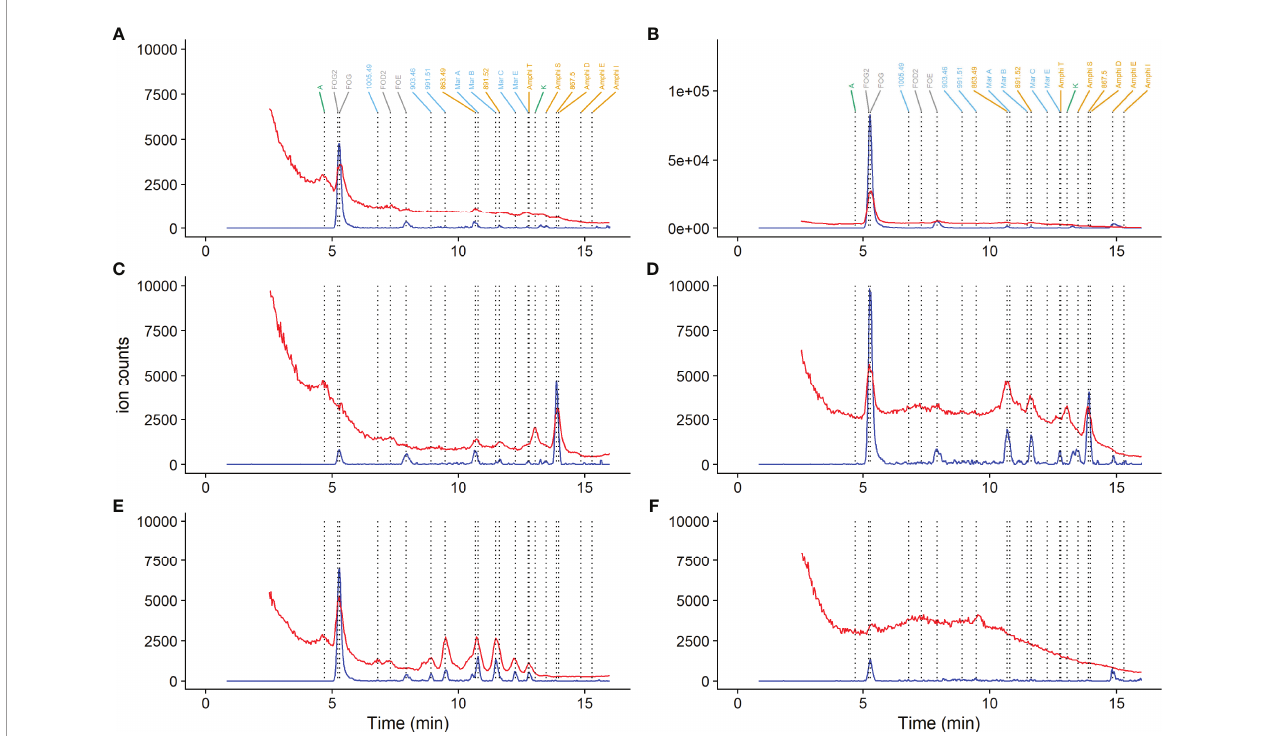
FIGURE 3 | Example chromatograms obtained in November 2014 from CCS (A, C, E) and CS2 (B, D, F) for the chlorophyll maximum (A, B) , subsurface samples (C, D) and bottom depths (E, F) . The red line is for the abundance of 56 Fe obtained by ICP-MS and the blue line the extracted ion chromatogram for the sum of all [M-2H+Fe] + ions given in Table 1 . Ion intensity was normalised relative to extraction volume. Ions are coloured according to siderophore group, with N 6 siderophores indicated in grey text, N 7 in orange text, N 9 in blue text and unknown in green text. The key to peak labels is given in Supplementary Table 2